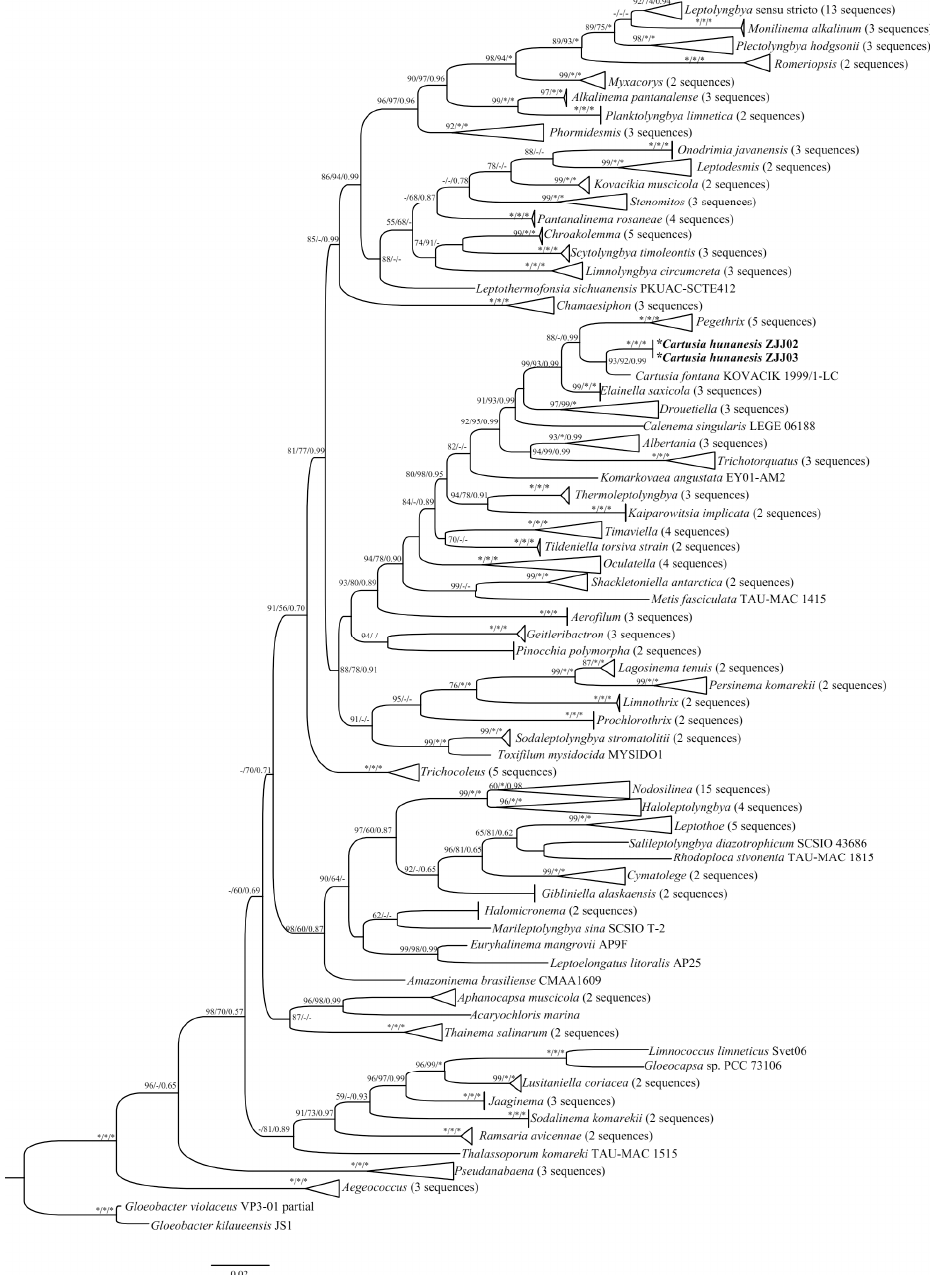
Figure 3. Maximum likelihood (ML) phylogenetic tree based on 16S rDNA sequences (1144 bp) of the studied strains and other cyanobacterial strains. Bootstrap values greater than 50% with the ML/NJ/Mrbayes methods are indicated on the tree, the asterisks and - at the nodes mean 100 and bootstrap value less than 50%. The novel species are in bold font.